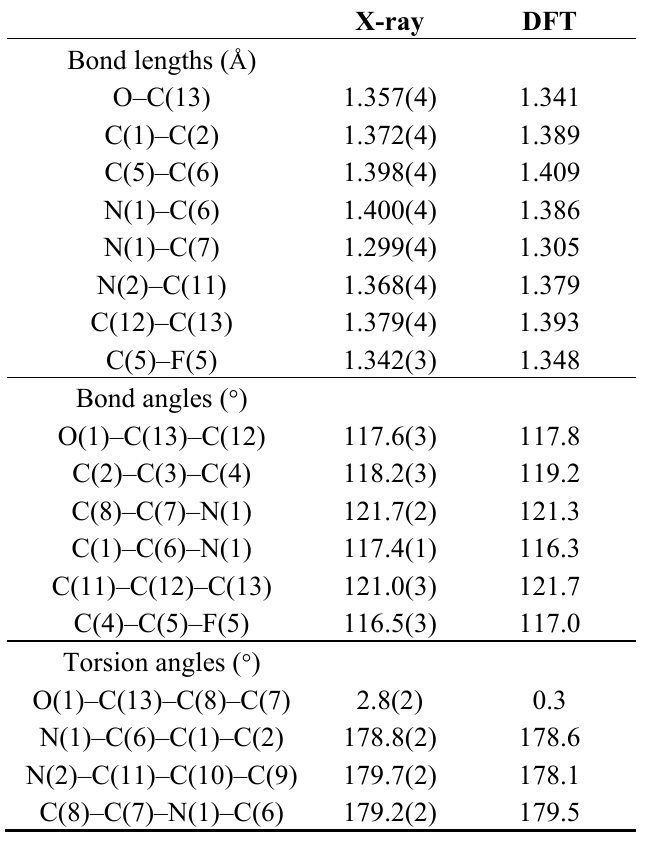
Table 2. Comparison of the experimental and optimized geometric parameters of 4 (Å and °).